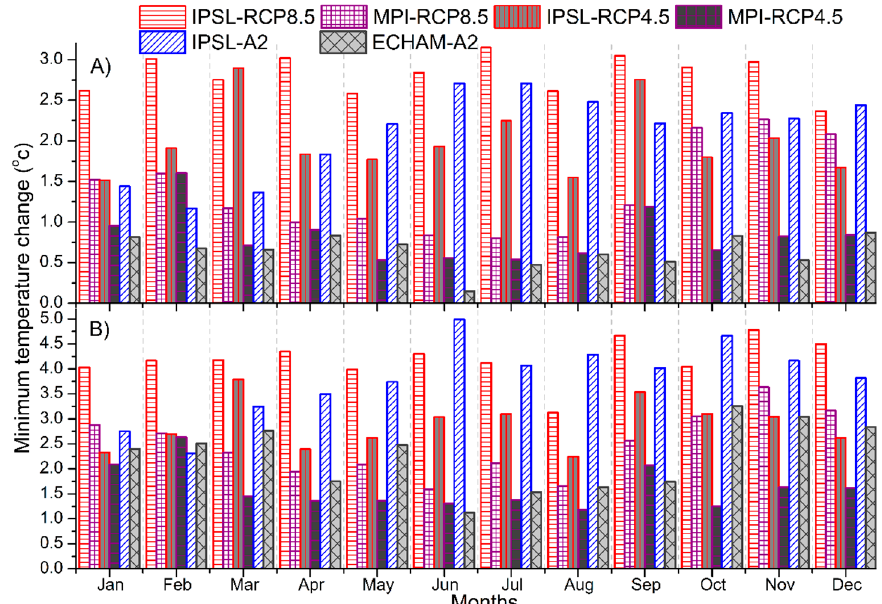
Figure 9. Changes of the monthly maximum temperature for ( A ) the near future period of 2021–2050 and ( B ) the far future period of 2071–2100, with respect to the baseline.